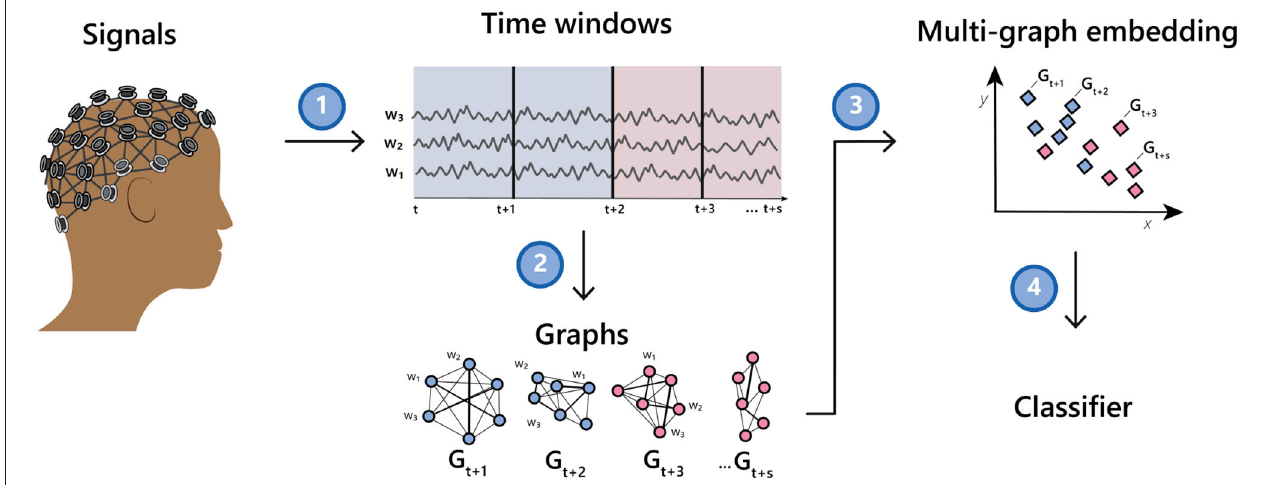
FIGURE 1 | Illustration of going from a multi-channel EEG recording to a classifier via a time series of graphs.